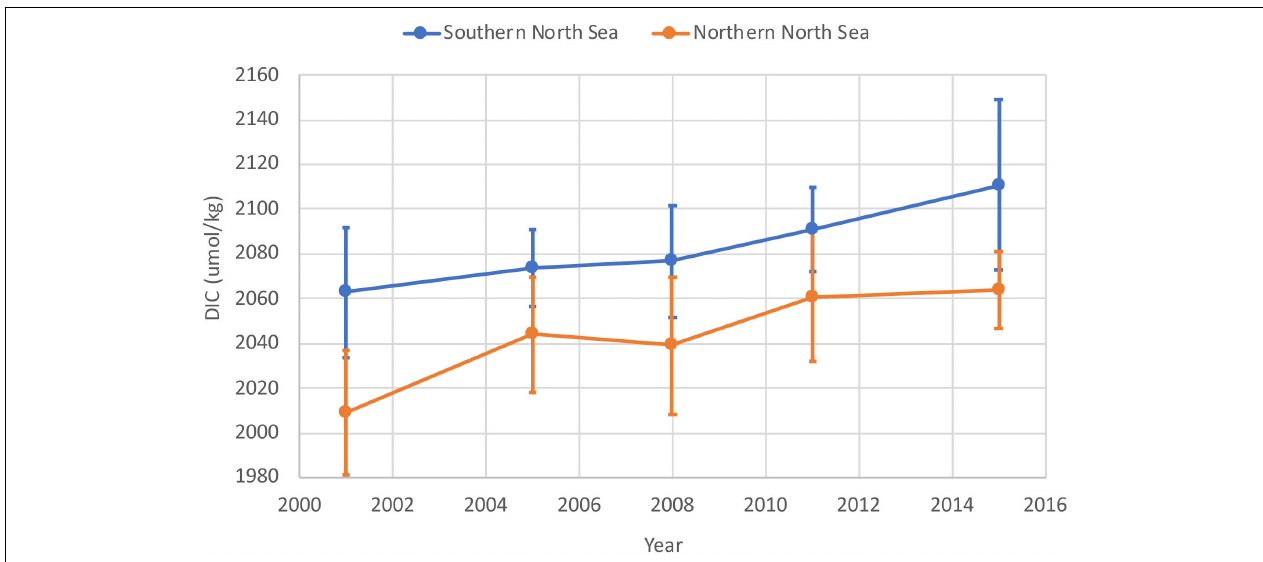
FIGURE 7 | Observations of increasing dissolved inorganic carbon concentration in summer in waters of the northern North Sea (orange) and southern North Sea (blue). Data 2001–2011 from Clargo et al. (2015) and from 2015 from Hartman et al. (2018). Vertical bars represent ± 1 standard deviation of the range of observed values across the survey areas. Much of the intra-annual variability represents spatial variability, and increases in the mean values through time is representative of the real increase in the DIC inventory in the region (Clargo et al.,